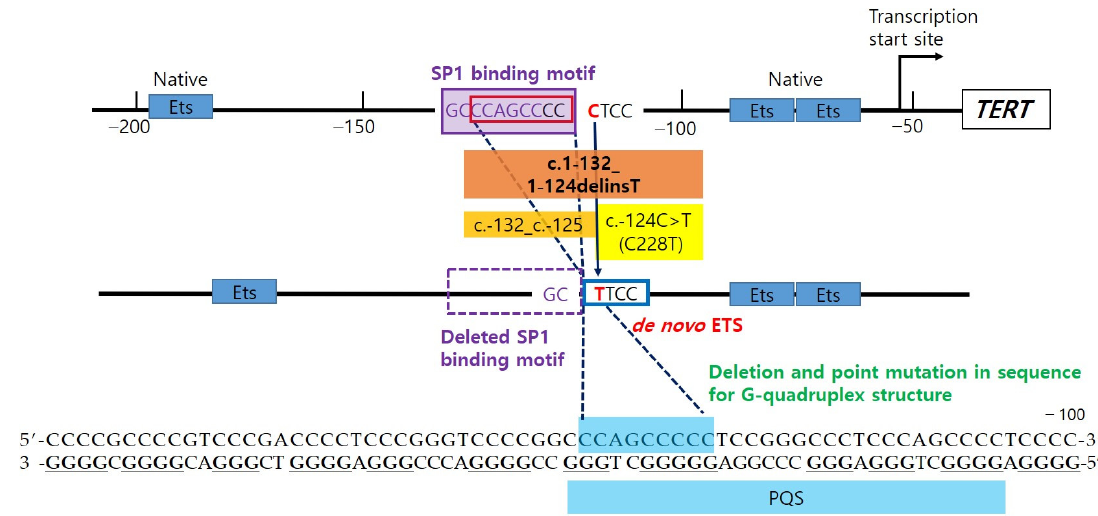
Figure 4. c.1-124C>T creates de novo E26 transformation-specific (ETS), which cooperates with native ETS, to recruit activating transcription factor (GA-binding protein, GABP). c.1-132_1-125 deletion (8bp, 1.3 helix turn) eliminates the transcription factor SP1 binding site, which is identified using TFBIND (http://tfnbind.hgc.jp/), and it also closes the distance between native ETS and de novo ETS (C228T). In addition, the mutations are located in the putative quadruplex sequence (PQS) that are able to fold in G-quadruplex structure.